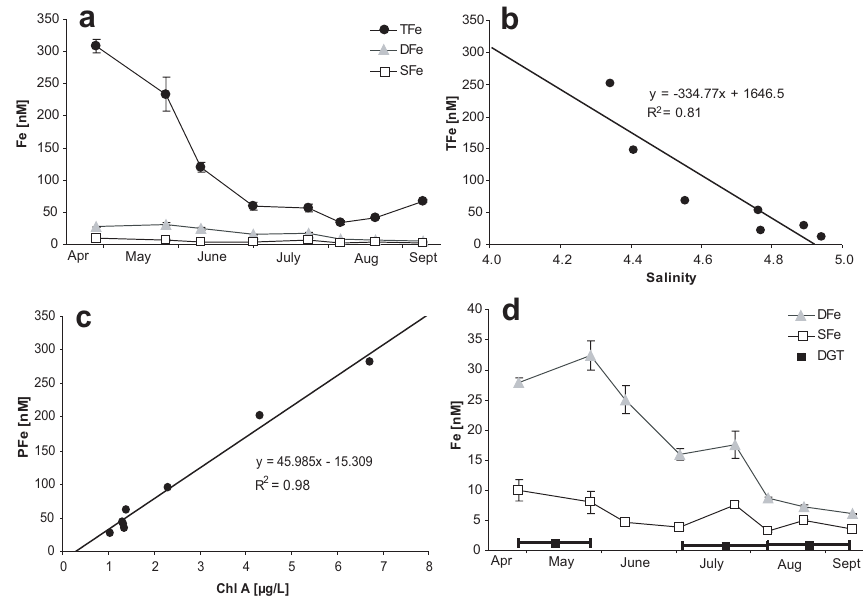
Fig. 4. Bothnian Sea 2006. Concentrations of TFe (total Fe), DFe ( < 0.22µm) and SFe ( < 1kDa) (a) . Regression between unfiltered Fe and Salinity at 5m depth, May to September (b) . Regression between chlorophyll- a and suspended Fe (PFe) (c) . Concentrations of DFe( < 0.22µm), SFe( > 1kDa) and DGT-labile Fe ([Fe] DGT ) (d) . For DGT measurements, the vertical lines indicate the time period for the measurement, and the filled square represent the mid-date.